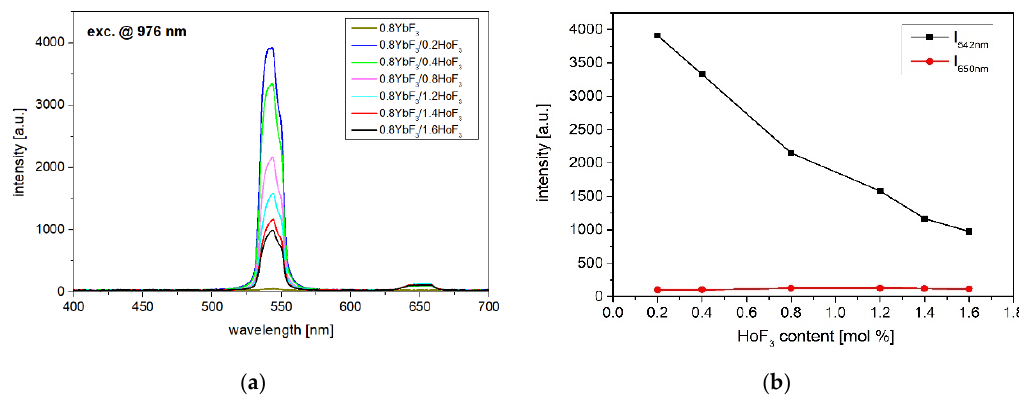
Figure 4. ( a ) Upconversion luminescence spectra and ( b ) intensity of upconversion emission bands of 0.8YbF 3 /(0.2–1.6)HoF 3 co-doped fluoroindate glasses, λ exc = 976 nm.